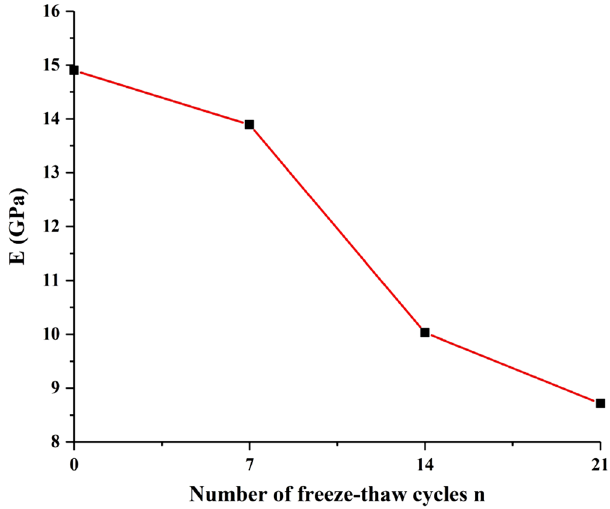
Figure 7. Elastic modulus of sandstone with different freeze–thaw cycles.